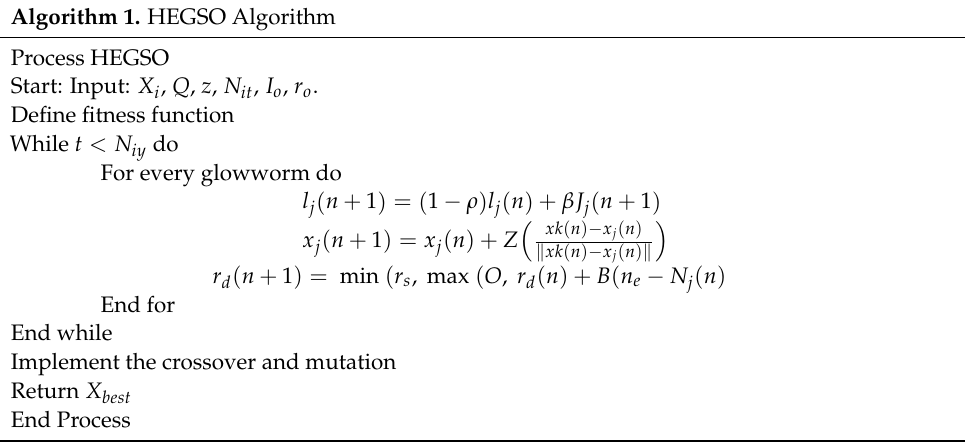
Algorithm 1. HEGSO